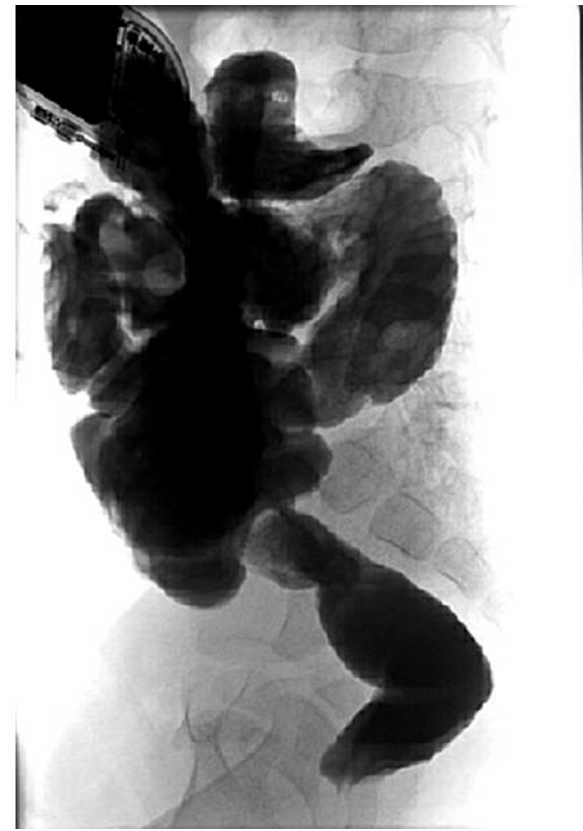
Fig.6 Contrast enema6 weekspostoperatively demonstratingawell- con fi gured colon and rectum without stenosis or